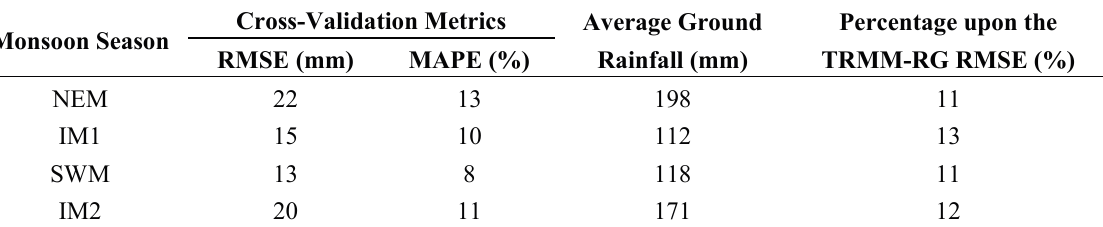
Table 3. Cross-validation on the high resolution areal interpolated